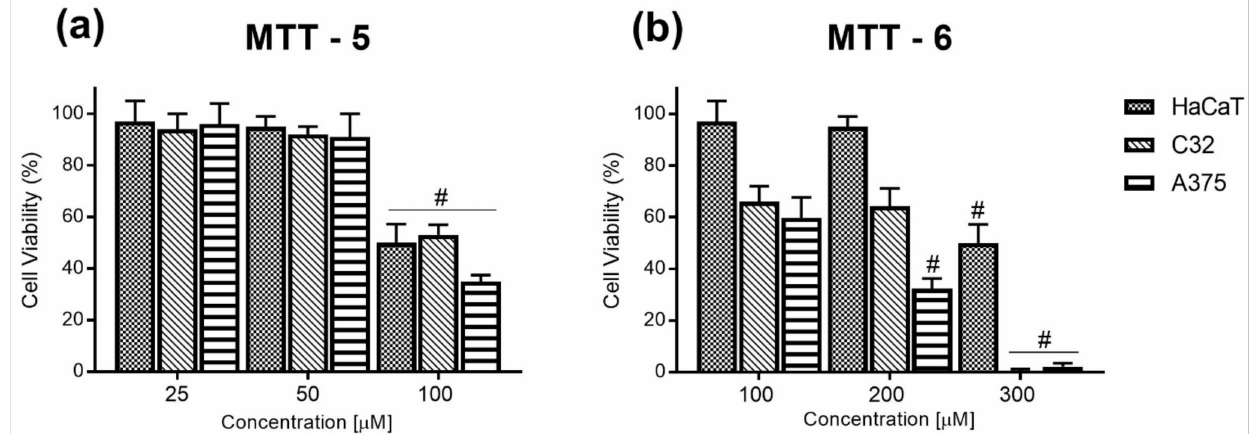
Figure 3. The cell viability after 24 h exposure to ( a ) compound 5 and ( b ) compound 6 , determined by the MTT colorimetric assay in skin cancers: melanotic (A375) and amelanotic (C32) melanoma cells and human keratinocytes (HaCaT). # p ≤ 0.05. Table 1. Cytotoxicity index IC 50 for compounds 5 and 6 for all tested cell lines. Cell